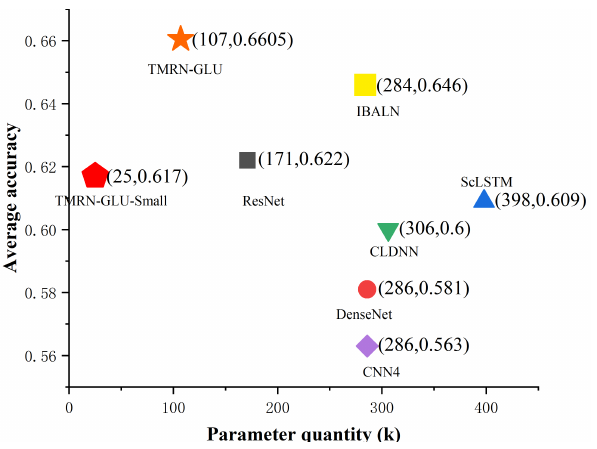
Figure 11. Average classification accuracy at all SNRs vs. Parameter